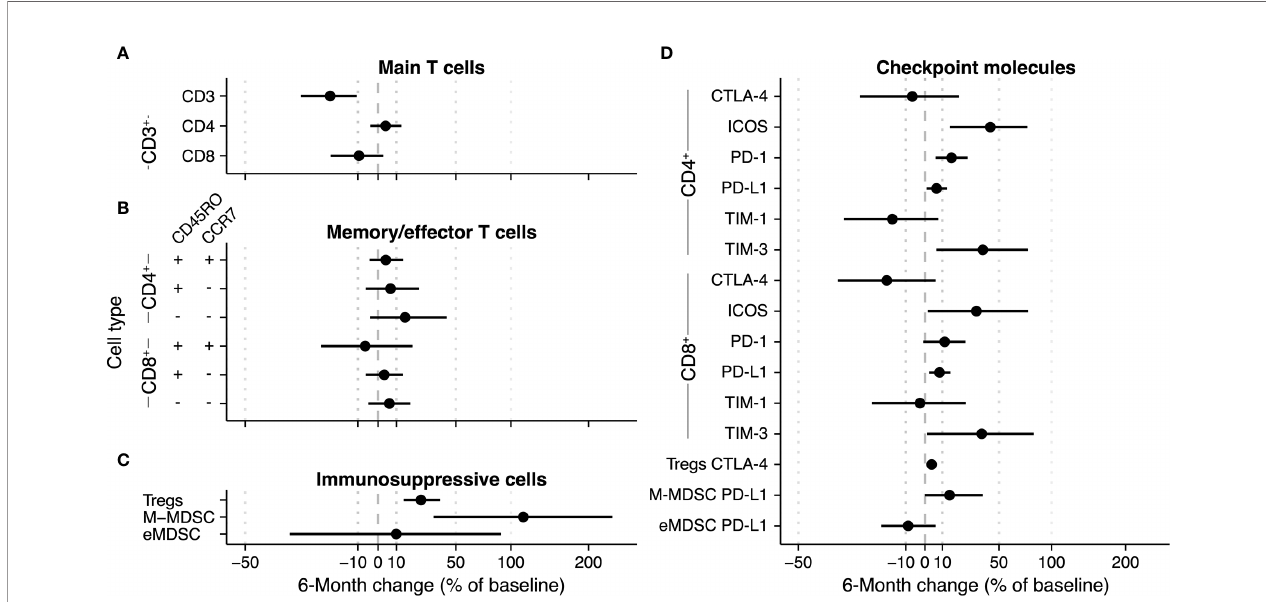
FIGURE 3 | 6-Month change estimate of immune cell subsets during radium-223 therapy. The percentage change relative to baseline is calculated using a bootstrap method. Per bootstrap, a linear model is fi tted on the logit-transformed and normalized bootstrap sample. Subsequently, the model predictions at baseline and after six months are used to calculate the change in (A) CD3 + , CD4 + , and CD8 + T cells, (B) memory/effector T cells, (C) immunosuppressive cells, and (D) checkpoint-expressing T cells and monocytes.